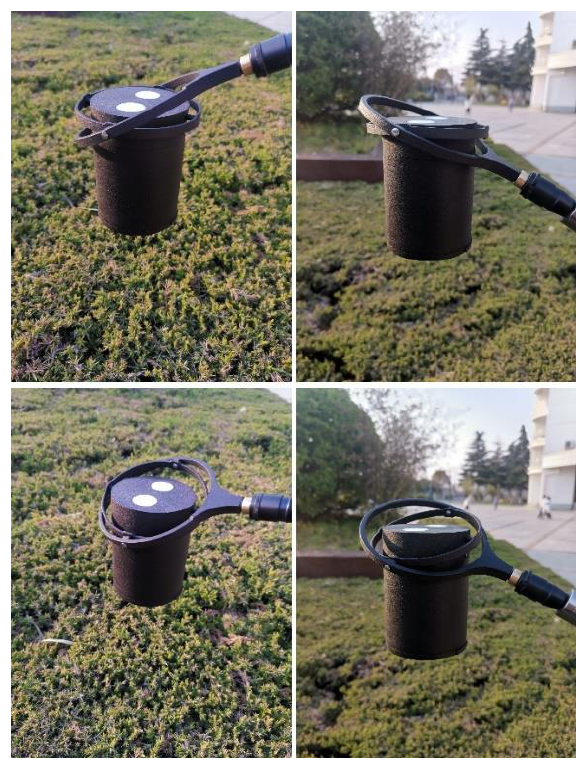
Figure 18. Automatic balancing of the sensor.